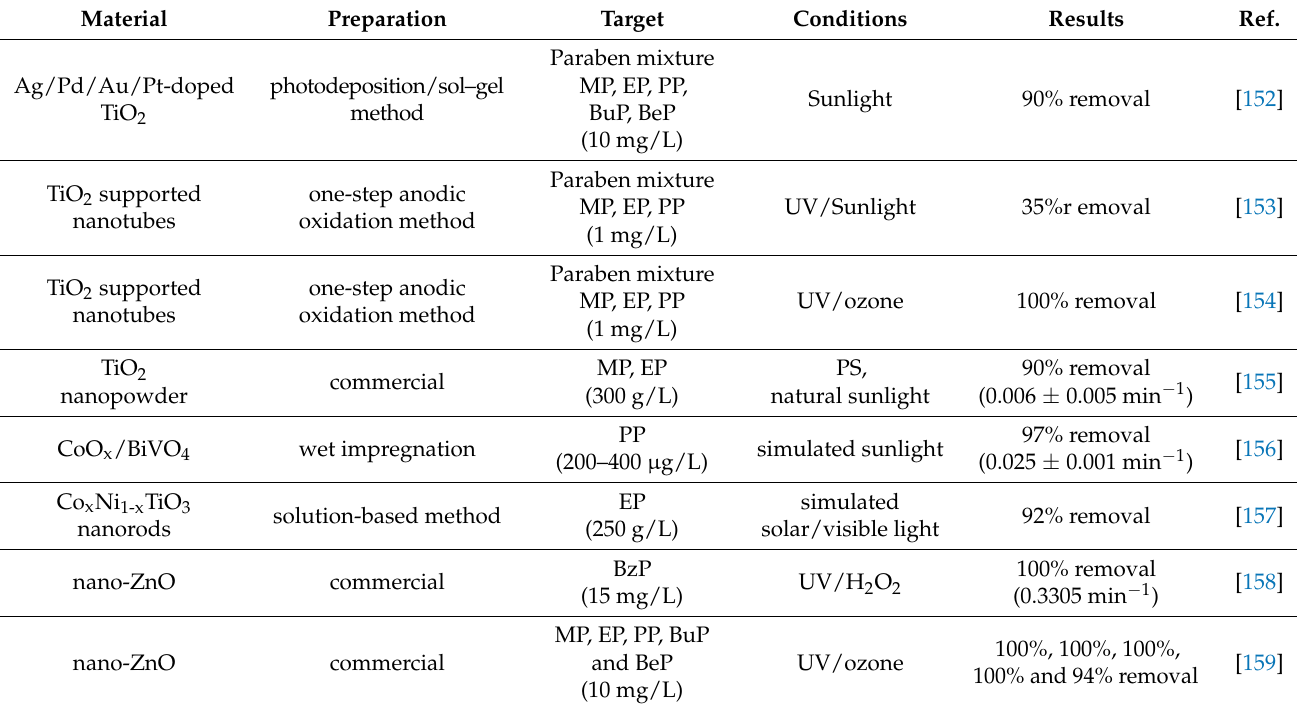
Table 5. Summary of representative metal-oxide-based nanomaterials used for the degradation of